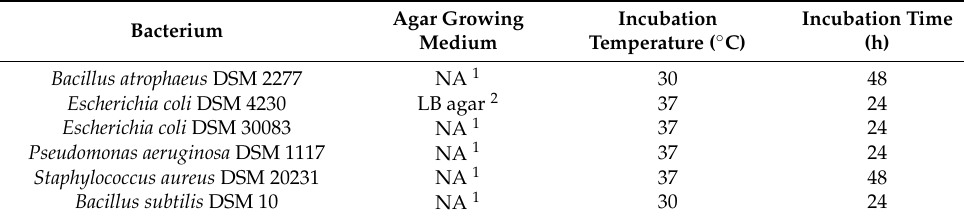
Table 1. Incubation conditions for bacteria cultivation in agar medium